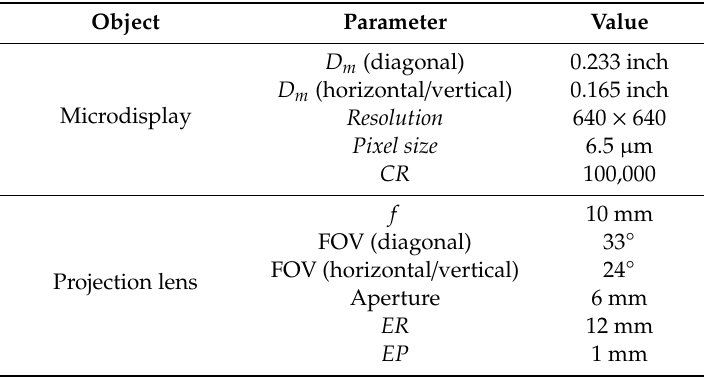
Table 2. Parameters of the pico projector.